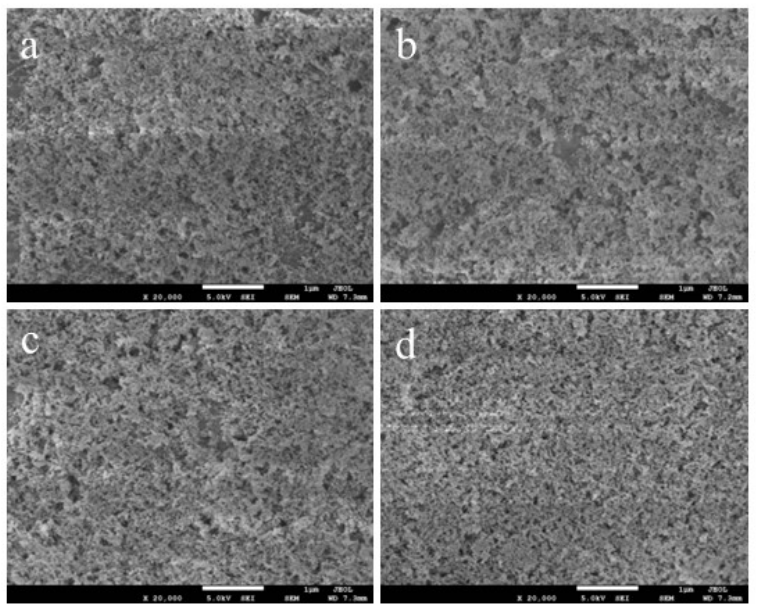
Figure 5. Microstructure images of hydrophobic coatings with silica content of 10%, 20%, 30%, and 40% are presented in ( a – d ).